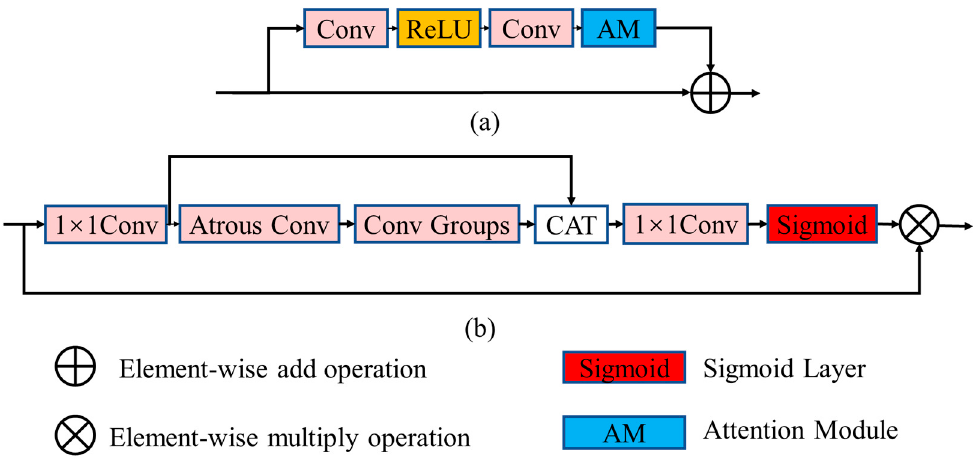
Figure 5. ( a ): The enhanced spatial residual attention module (ESRAM). ( b ): Details of the attention module mechanism.